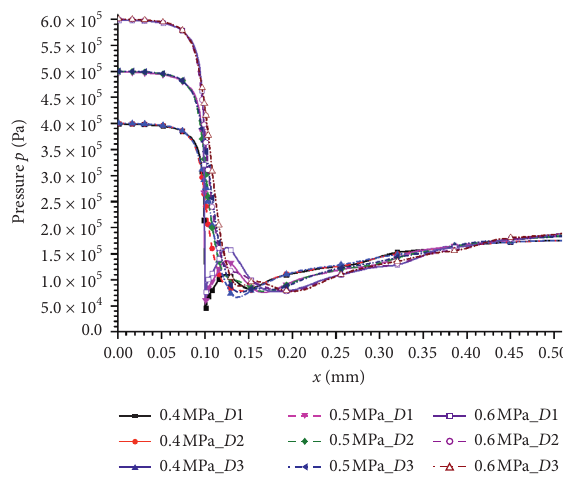
Figure 7: Curves of the pressure of the gas film at different p